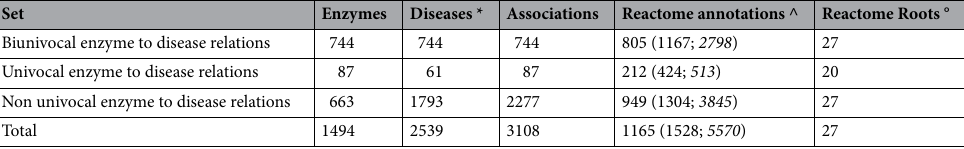
Table 1. Dataset description. * The same disease can appear in more than one list, ^ the same Reactome term can appear in more than one list; values between brackets indicate the expanded Reactome list from leaves to roots and the reaction numbers (in italic), respectively; ° the same Reactome root can appear in more than one list.